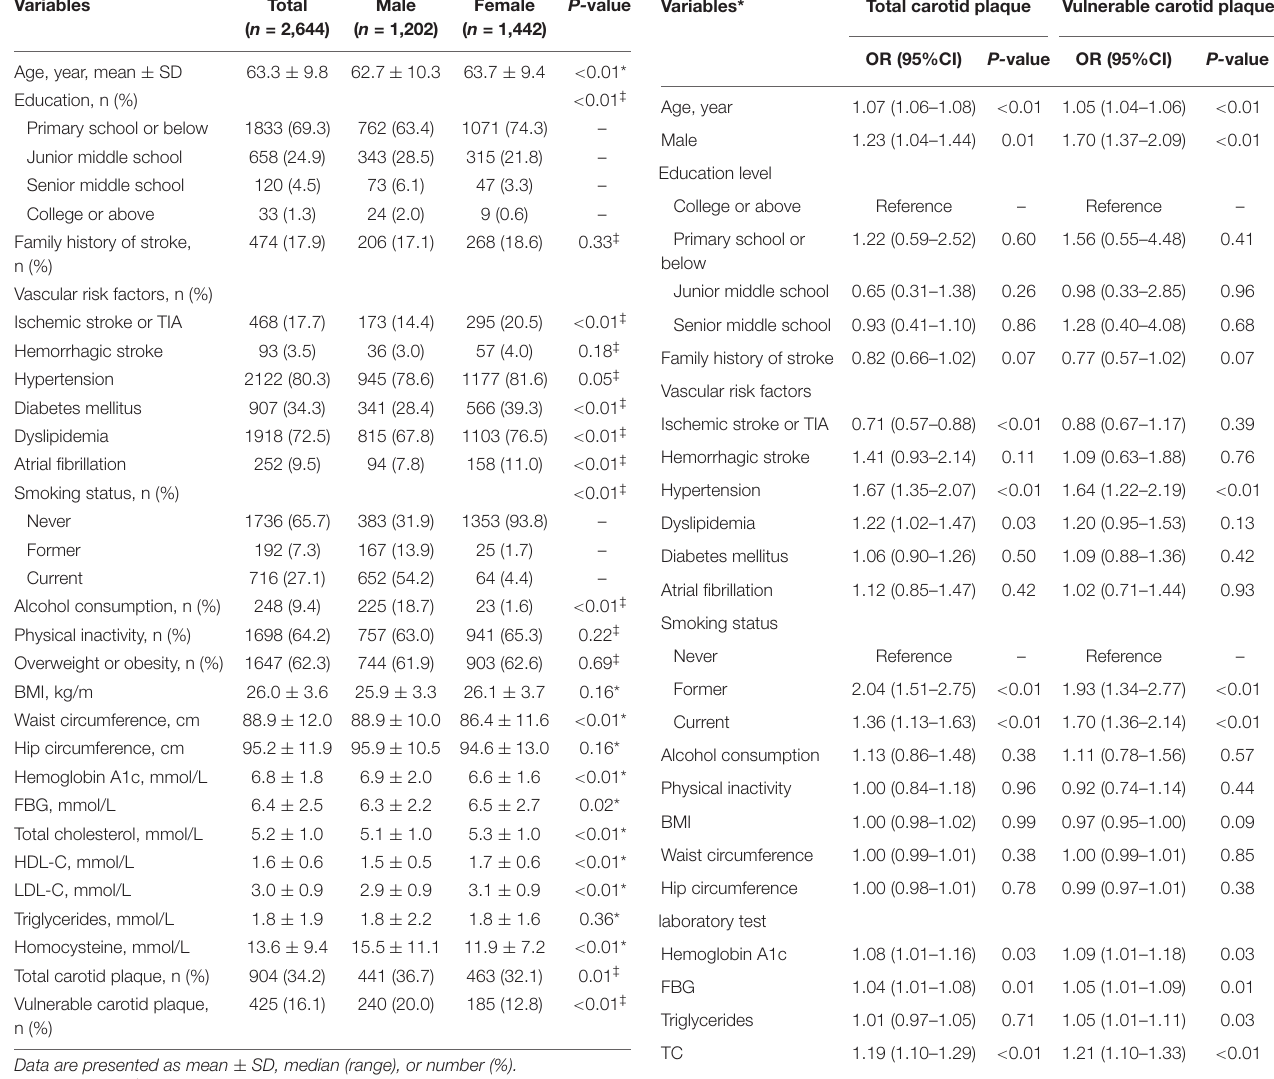
TABLE 2 | Univariable analysis for the factors associated with carotid plaques in a population at high risk of stroke. Variables* Total carotid plaque Vulnerable carotid